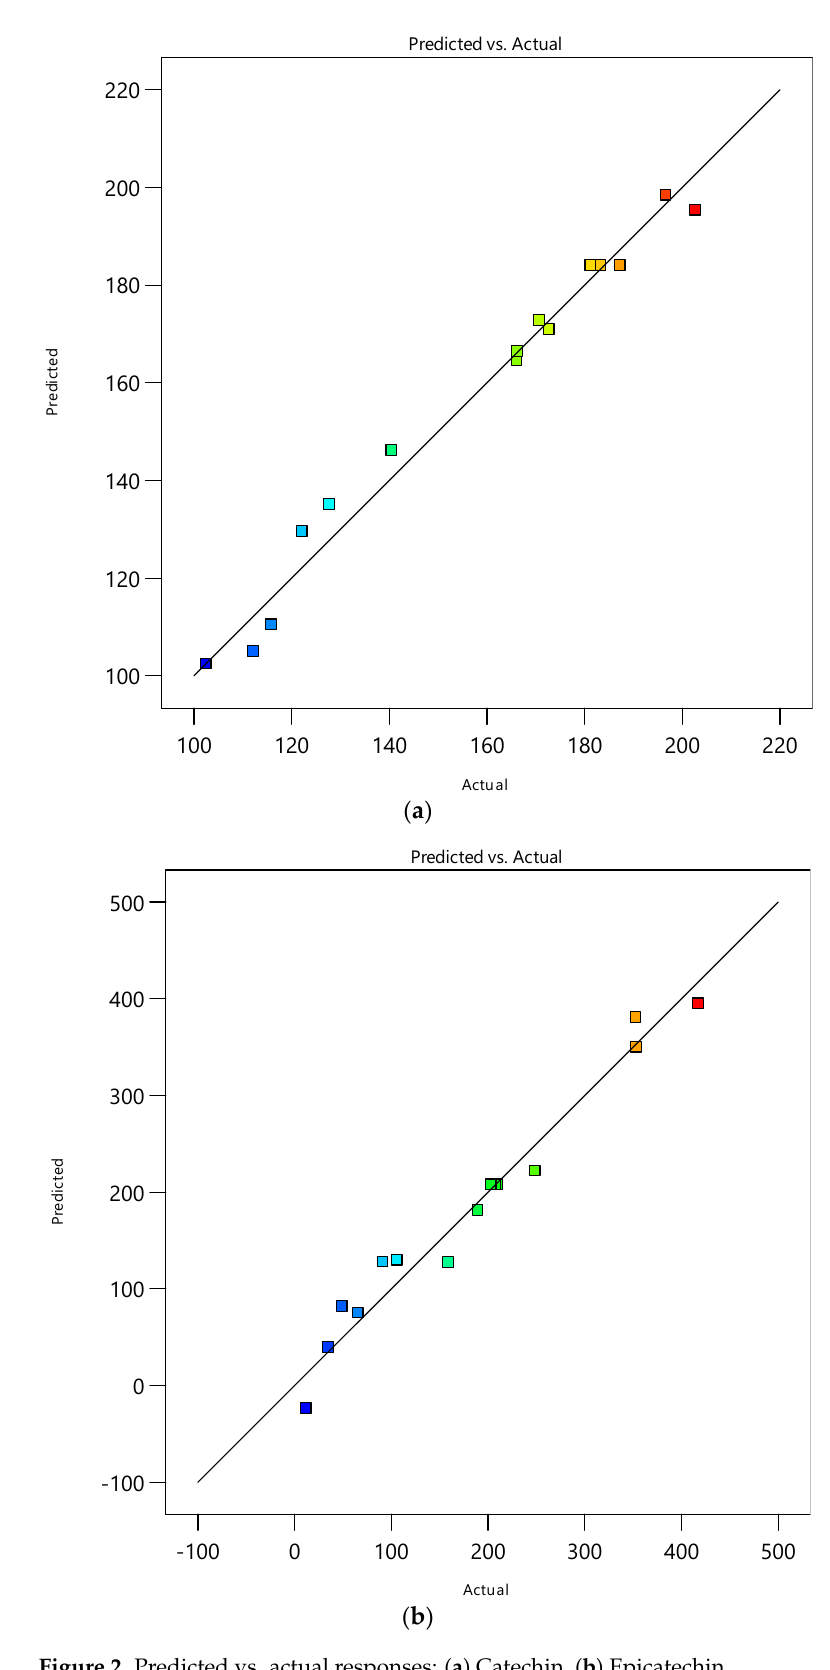
Figure 2. Predicted vs. actual responses: ( a ) Catechin, ( b ) Epicatechin. Table 2. ANOVA table of catechin recovery by SME.